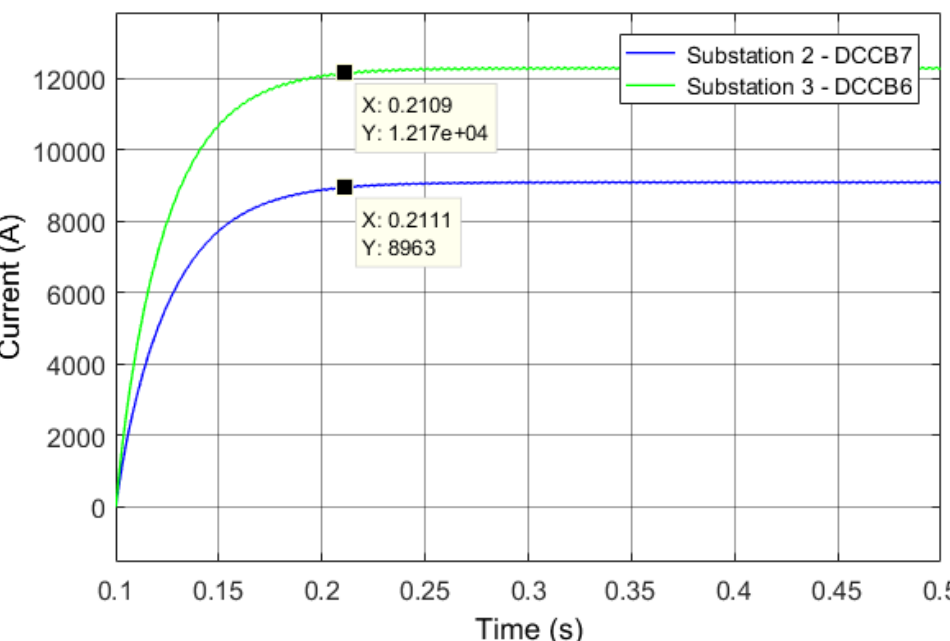
Figure 16. Simulation results of Scenario F3. Fault current (A) vs. time (s) observed with DCCB7 (TPH 1—blue), DCCB6 (Substation 3—green), DCCB2 (Substation 2—red), and the Substation 2 bus-